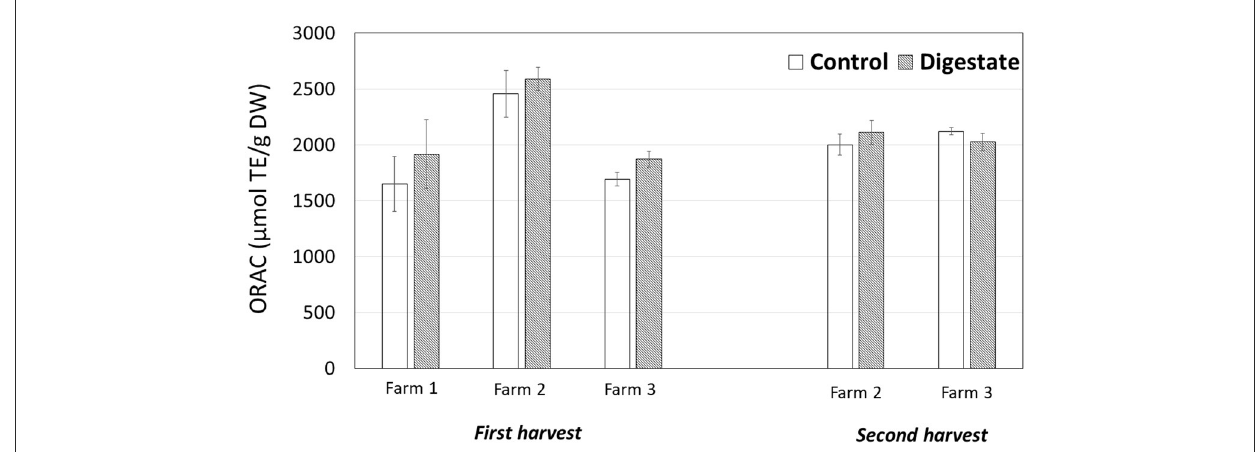
FIGURE2 Antioxidant activity of flesh orange juice obtained from citrus harvested in the three different farms. The data are expressed as mean ± SD; p ≤ 0.05.